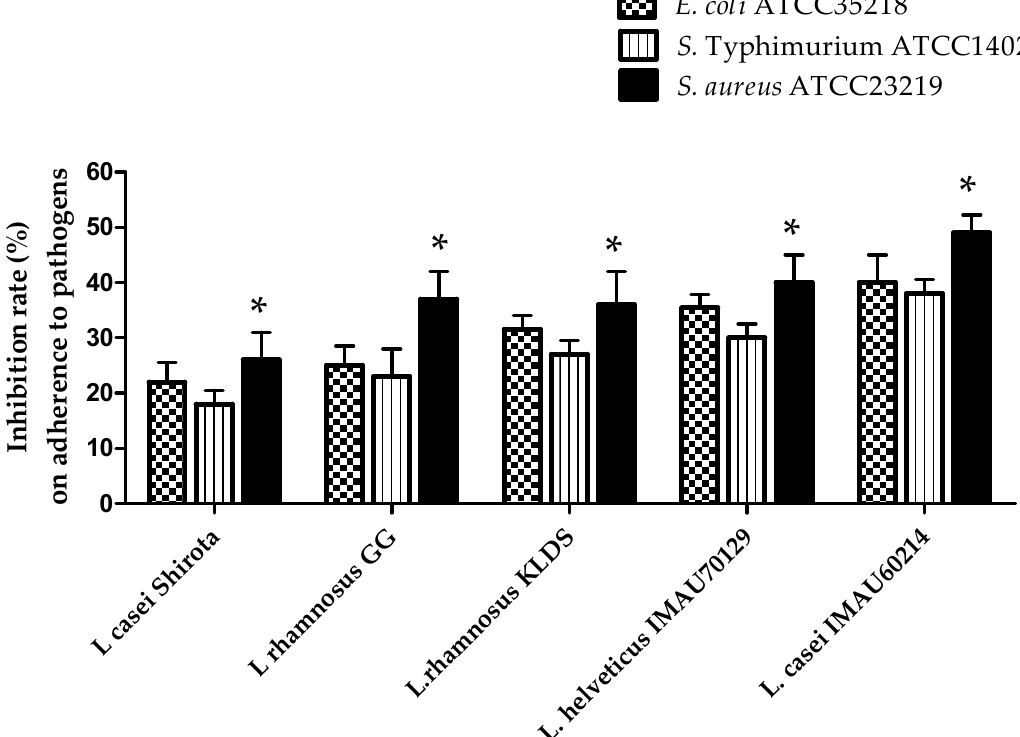
Figure 5. Adherence inhibition effect of Lactobacillus strains against pathogenic bacteria as well as Escherichia coli ATCC 35218 and Salmonella Typhimurium ATCC 40128 and Staphylococcus aureus ATCC 23219. The values represent the mean ± SD of three different assays. * significant among Lactobacillus strains ( p < 0.05).